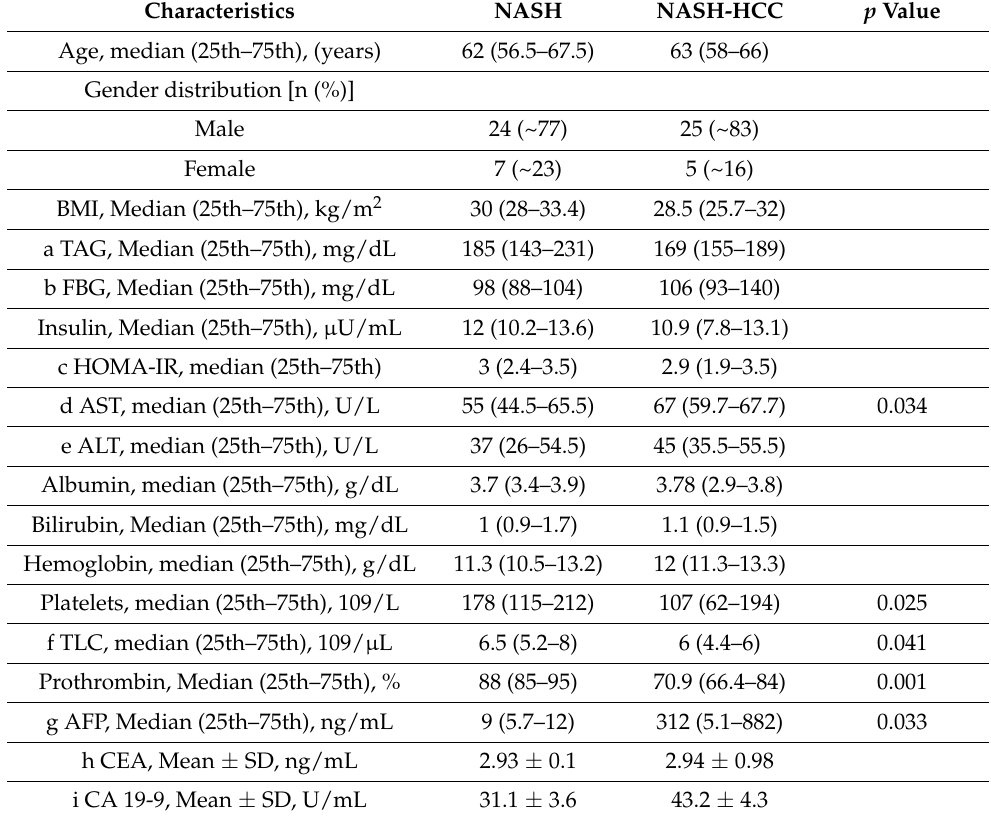
Table 1. Baseline clinical characteristics of NASH and NASH-HCC patients. Characteristics